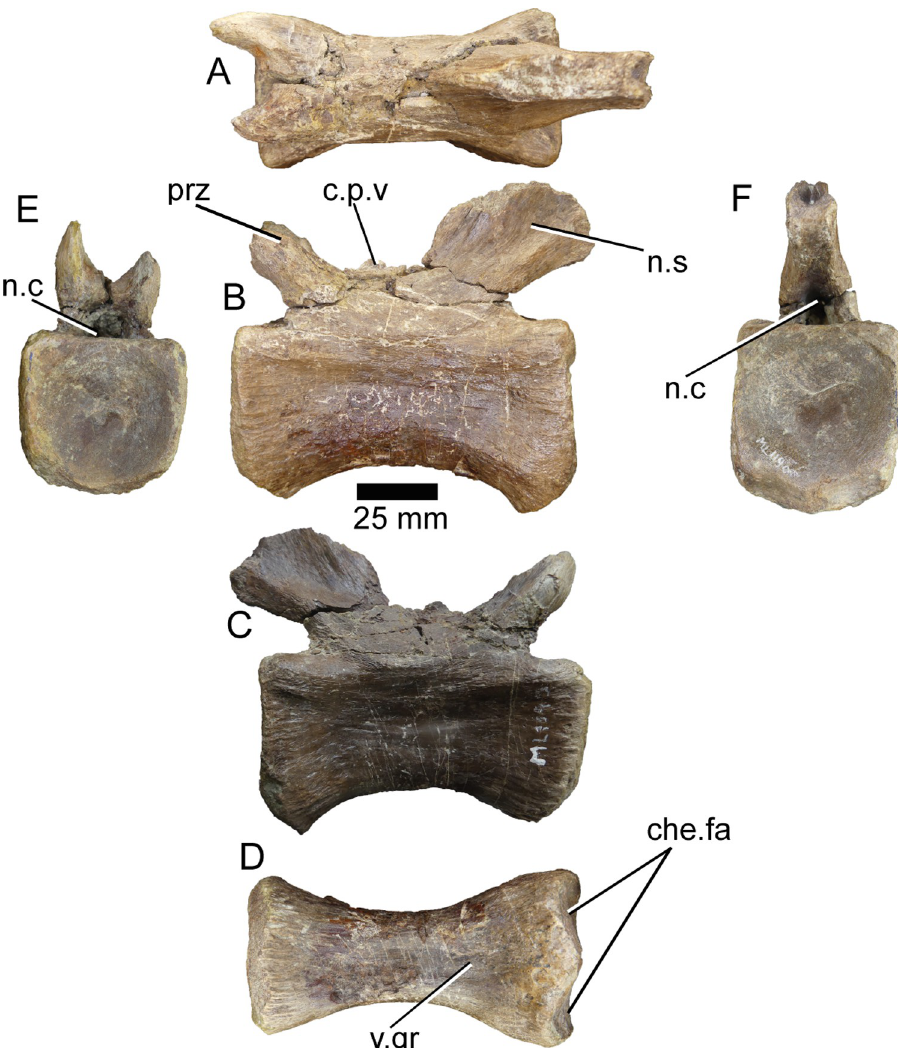
Fig 19. Caudal vertebra of Iberospinus natarioi (ML1190-19). A , dorsal, B, C; lateral, D , ventral, E , anterior, and F, posterior view. c.p.v , cranial process of the vertebra, che.fa , chevron facets, n.c , neural canal, n.s , neural spine, prz , prezygapophysis, v.gr , ventral